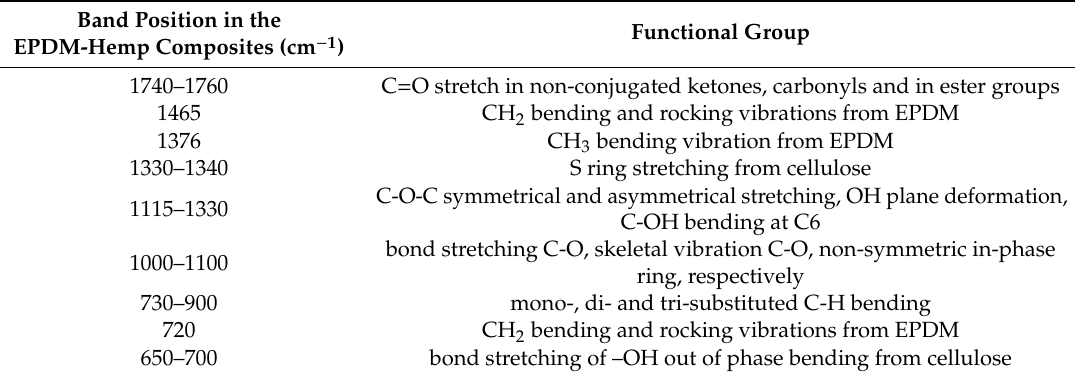
Table 5. Main spectral attributions in EPDM / hemp fibers